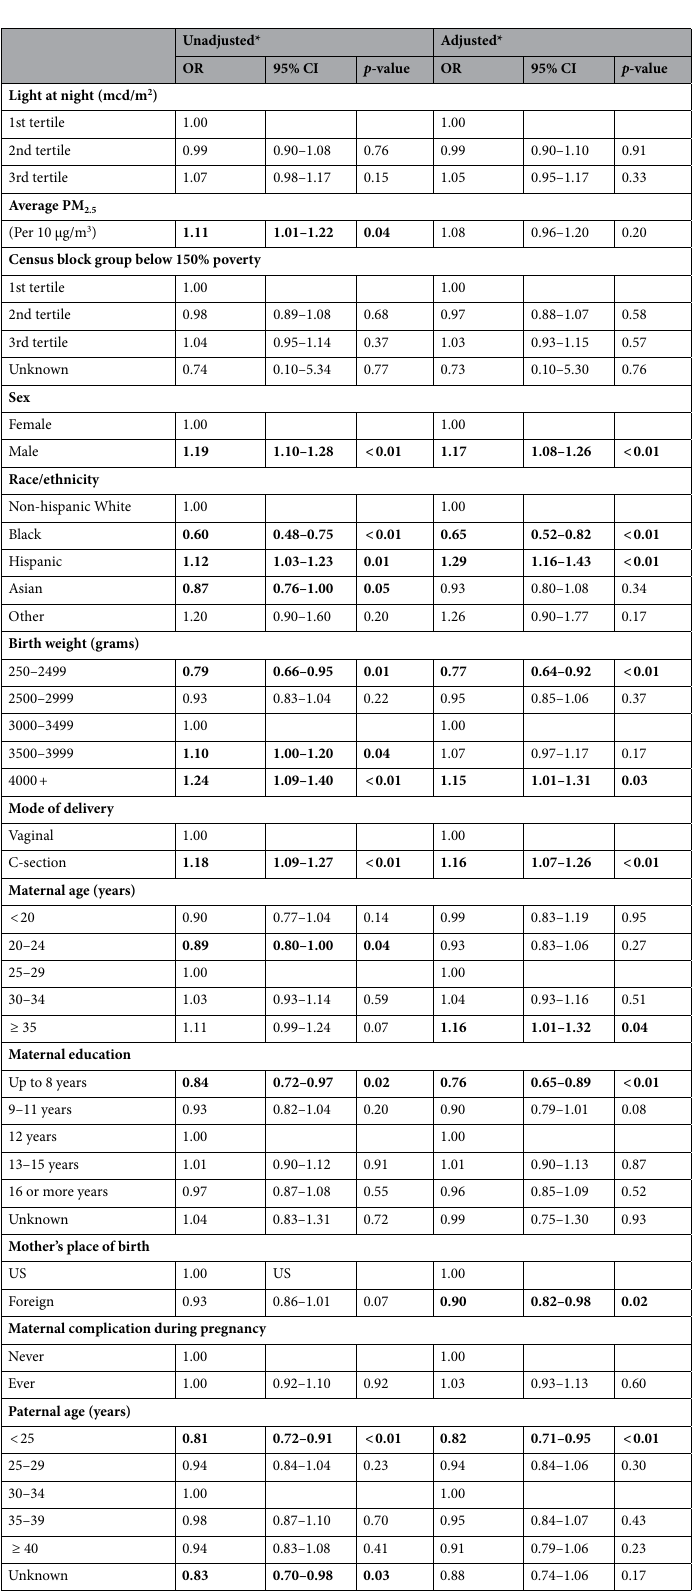
Table 2. Association between outdoor artificial light at night, air pollution, birth characteristics, and risk of childhood acute lymphoblastic leukemia in the California Linkage Study of Early-Onset Cancers. *Unadjusted odds ratios and 95% confident intervals were obtained from bivariate logistic regression models that included one independent variable at a time. Adjusted odds ratios and 95% confidence intervals were derived from a multivariable logistic regression model that simultaneously included all variables listed in this table. Significant values are in